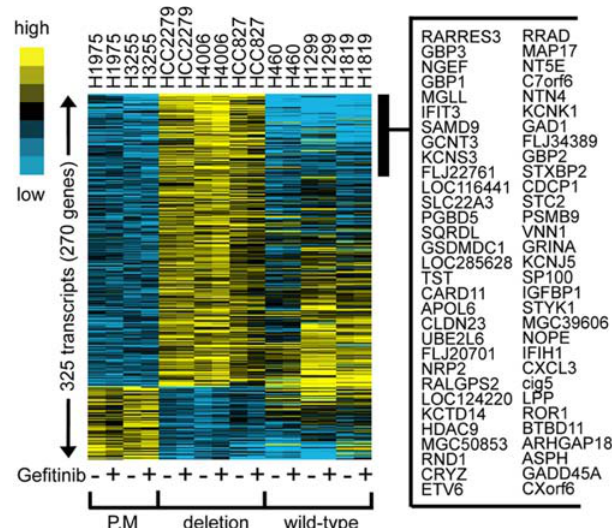
Figure 5. Expression signature that distinguishes two types of EGFR mutations. A 194-gene signature present in EGFR -mutant but not EGFR–wild-type cell lines distinguishes L858R (P.M. [point mutation]) from D 746–750 (deletion). Cells were treated with ( + ) or without ( 2 ) gefitinib. A partial list of the genes that are differentially expressed in the two groups is indicated on the